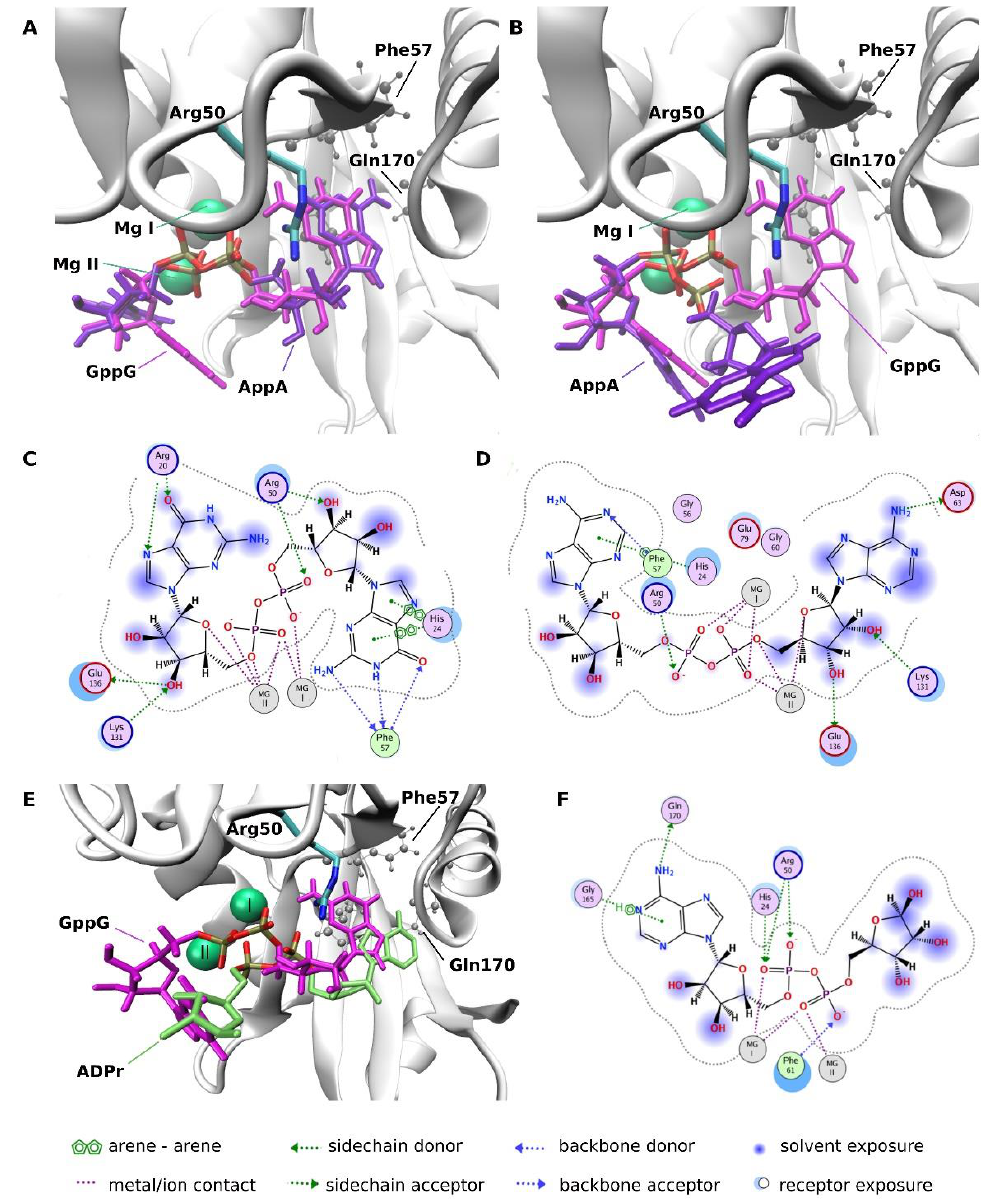
Figure 7. ( A , B ) Conformations of GppG and AppA bound to hNudt16 in mode 1. GppG remains in its active conformation, whereas adenine positions are less stabilized and one of the AppA adenines either stays inside ( A ) or flips out ( B ) of the pocket (marked with three residues, His24, Phe57 and Gln170 in ball and stick representation in gray). ( C , D ) SchematicillustrationofGppGandAppAinteractionsinactive conformations of mode 1 (ligand conformations as in ( A )). ( E ) Comparison of the ligand positions in active conformations of mode 1: a very good hNudt16 substrate, GppG, vs. the conformation of a poor substrate, ADPr (ADPr position is from the PDB:5W6X structure). ( F ) Schematic illustration of ADPr interactions with